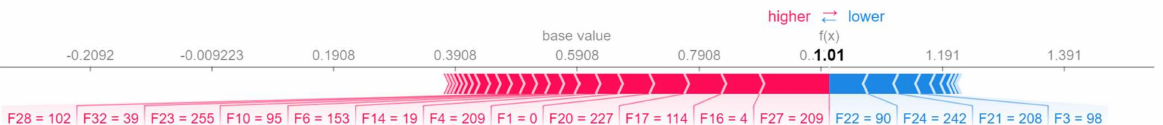
Figure 13. Waterfall plot shows how SHAP values of each feature affect model output compared to the data distribution.